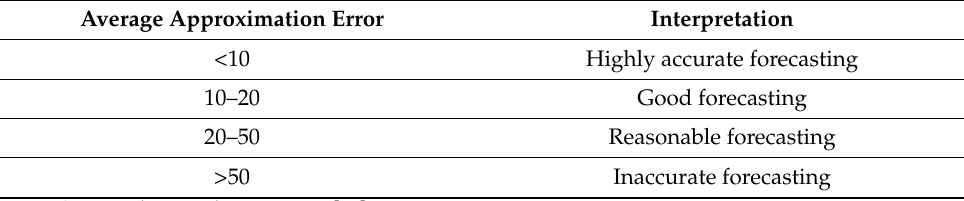
Table 3. Interpretation of average approximation